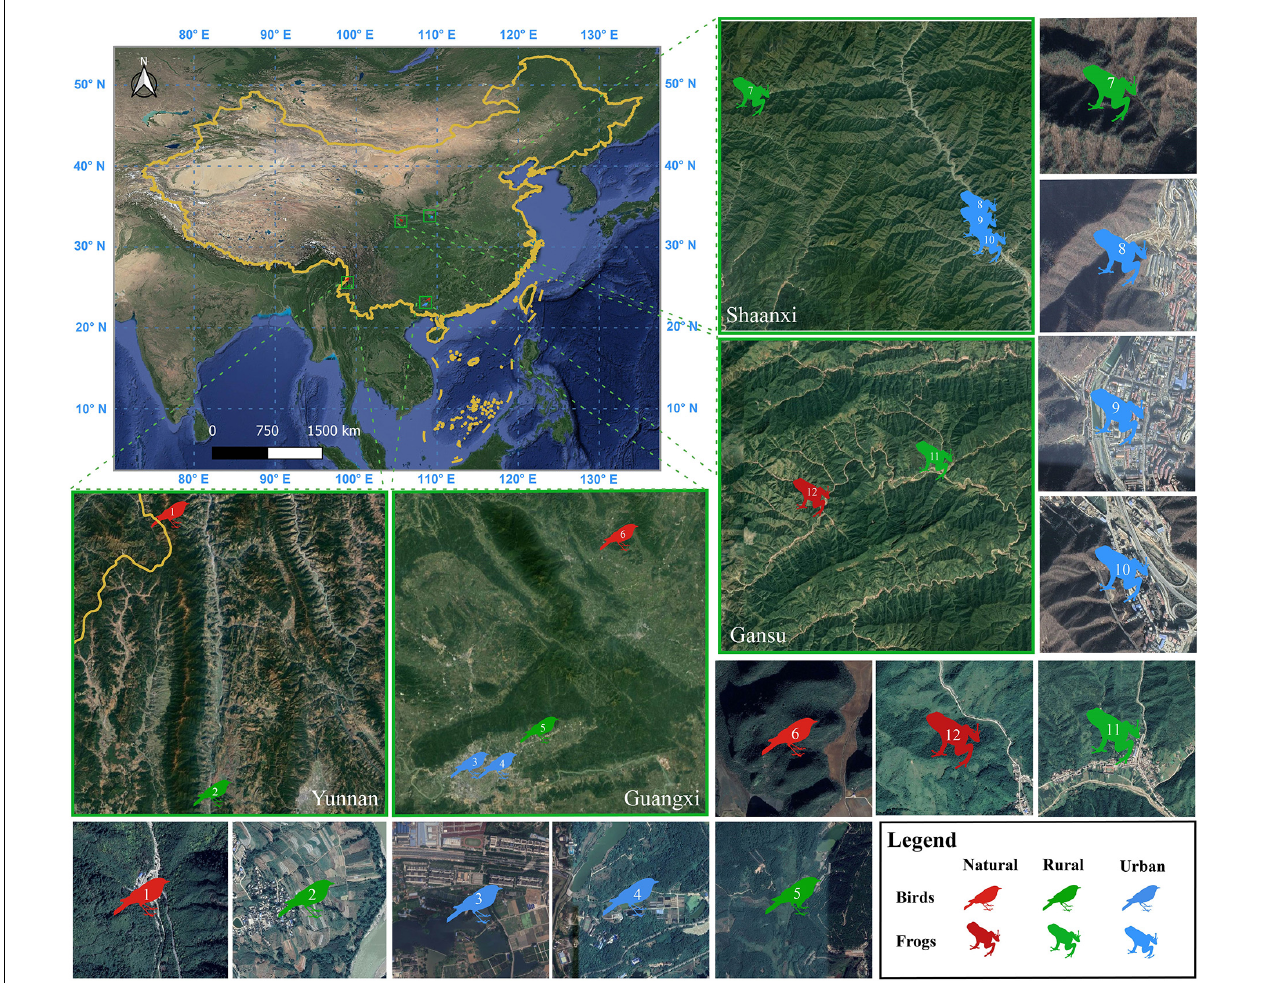
FIGURE 2 | Map showing our study locations in Guangxi Zhuang Autonomous Region and Yunnan Province (southwest China), and Gansu and Shaanxi Provinces (northwest China). Left top panel shows a general map of the People’s Republic of China. The four larger squares illustrate the distance among study locations and their general aspect. The smaller squares provide a closer look of these study